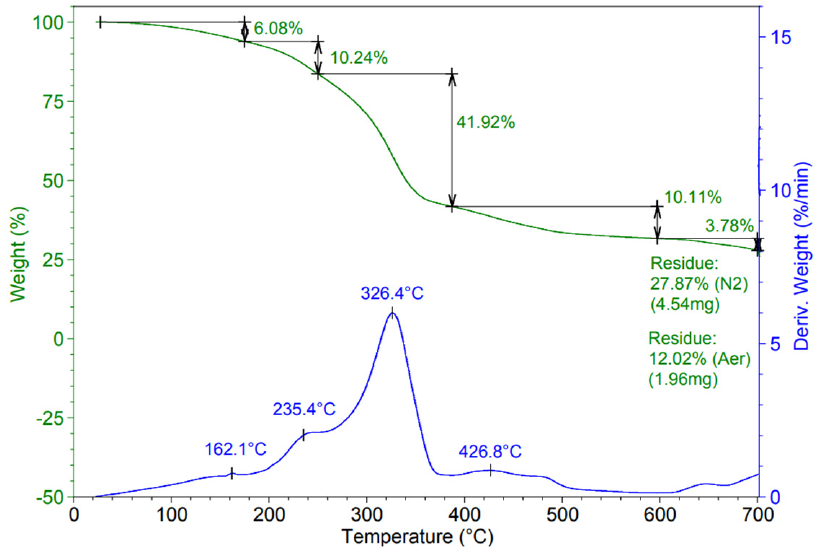
Figure 3. The thermal degradation of the selected quaternary starch - based compound.